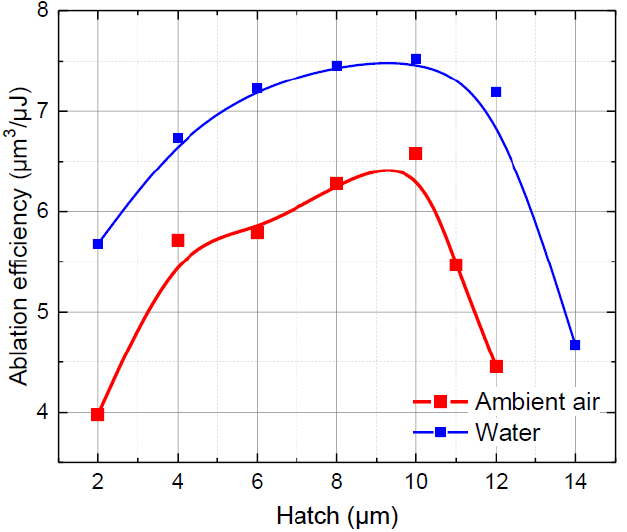
Figure 6. Ablation efficiency versus hatch distance in ambient air and water. Dots are connected to guide the eye.